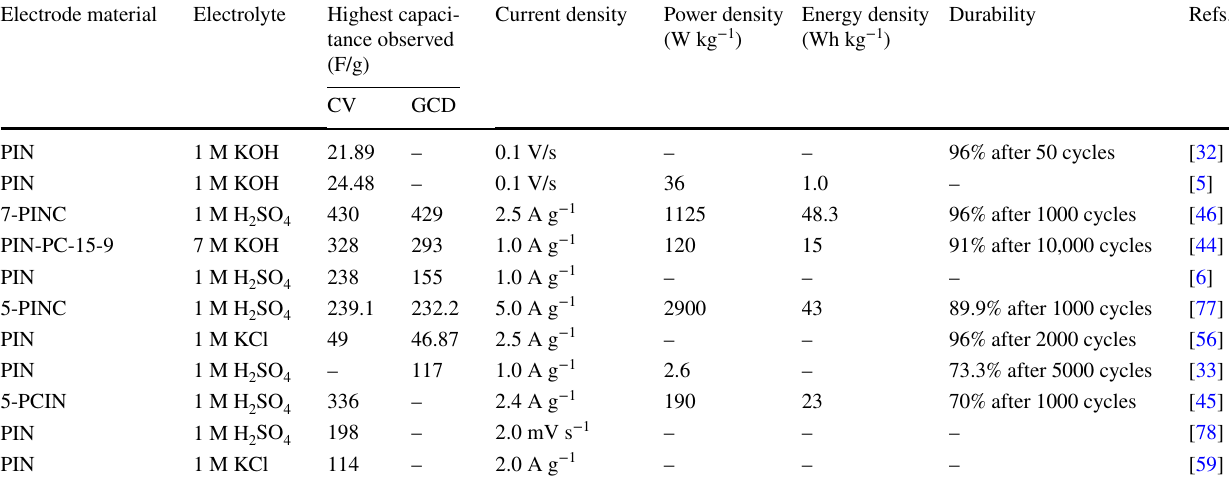
Table 2 Capacitance analysis of PIN and its derivatives Electrode material